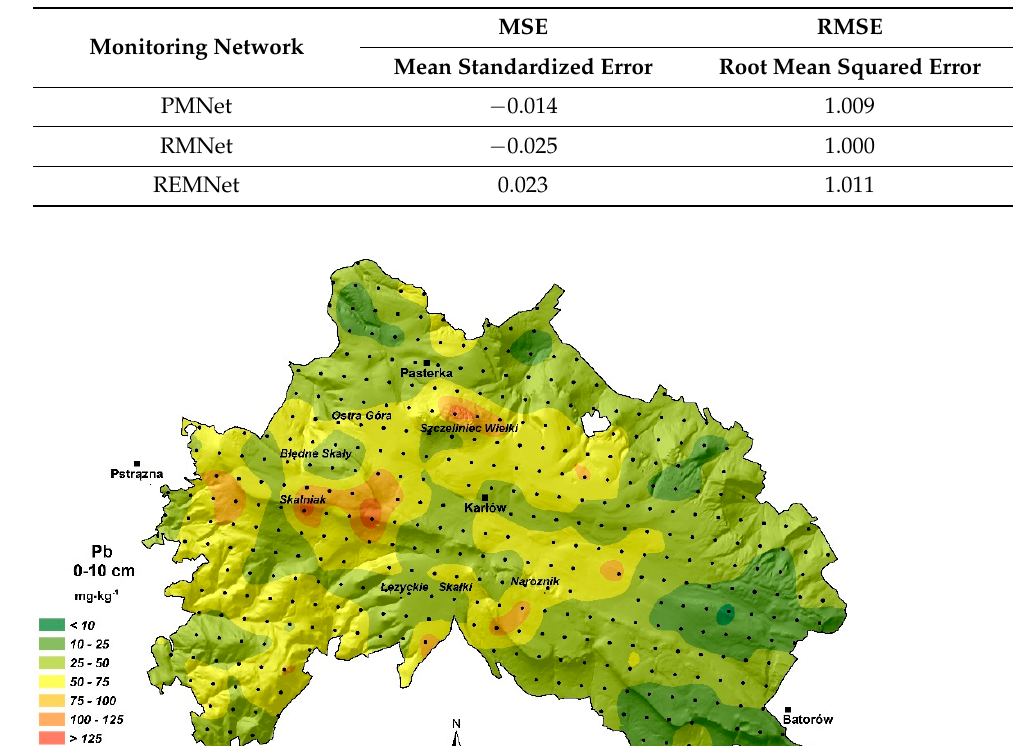
Table 3. Model errors for analysed monitoring networks.